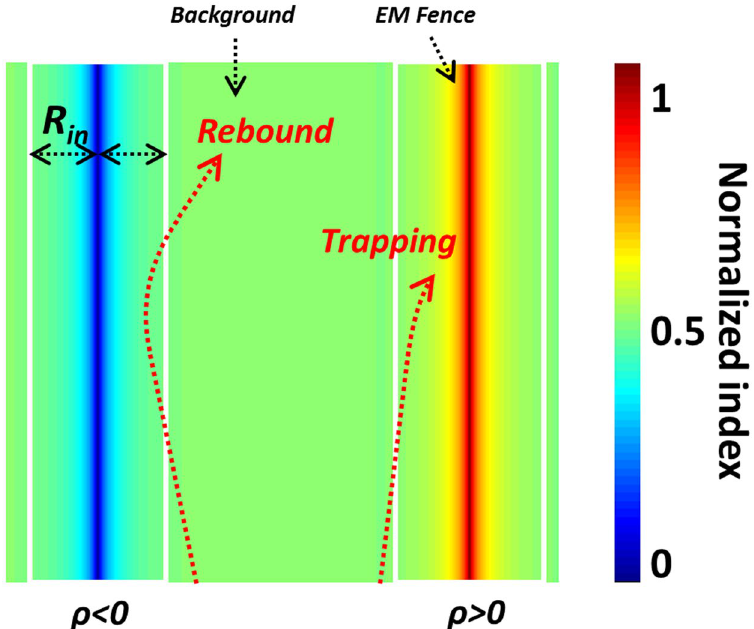
Figure 2. The schematic illustration of the influence of ρ on trapping performance.